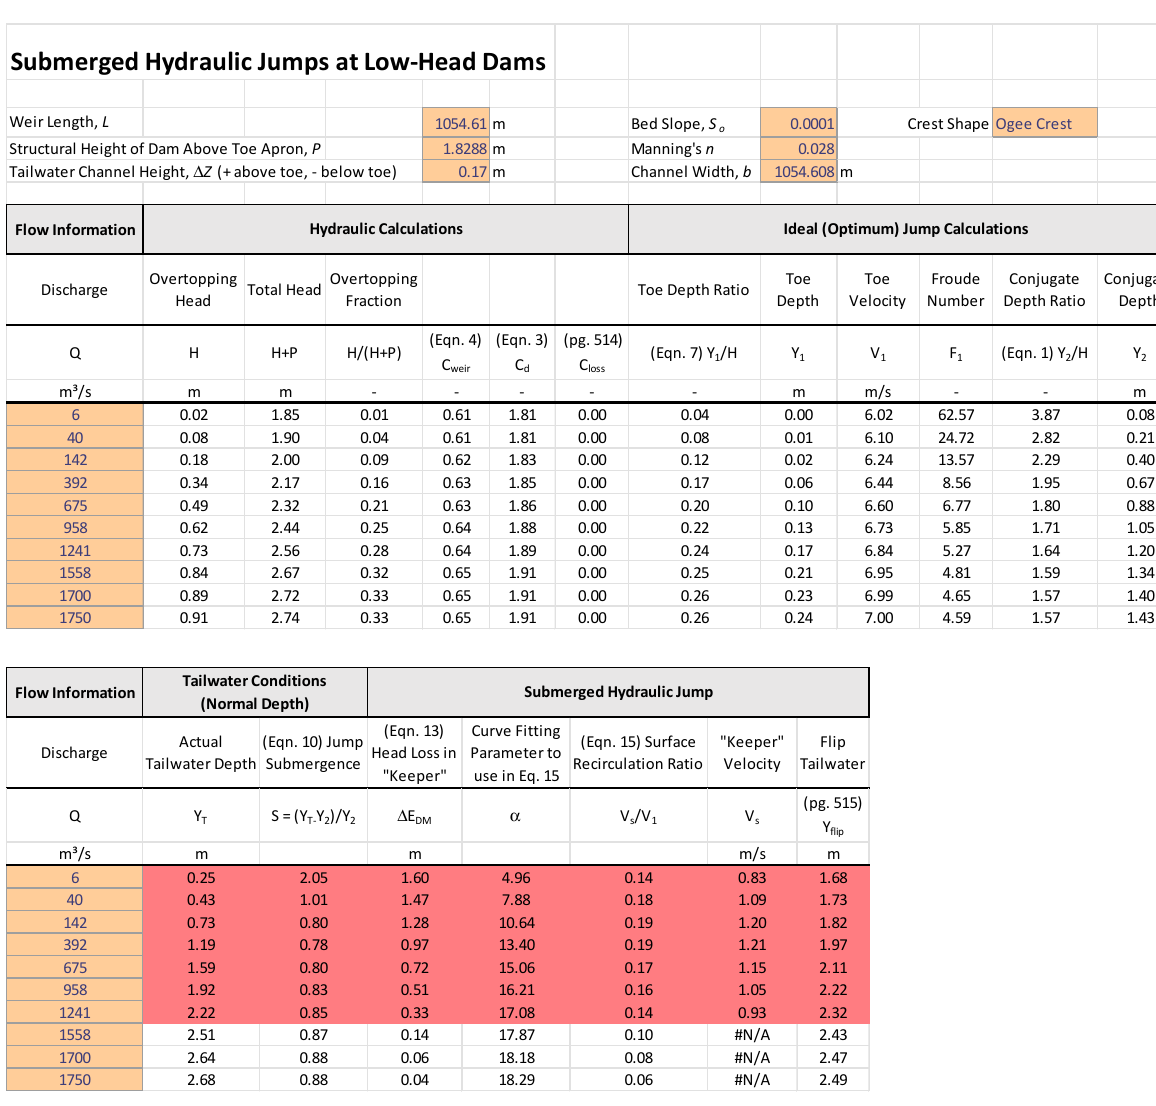
Figure 4. Example spreadsheet used to evaluate low-head dams for dangerous flow conditions. Red-shaded cells are in the Case C submerged hydraulic jump range.